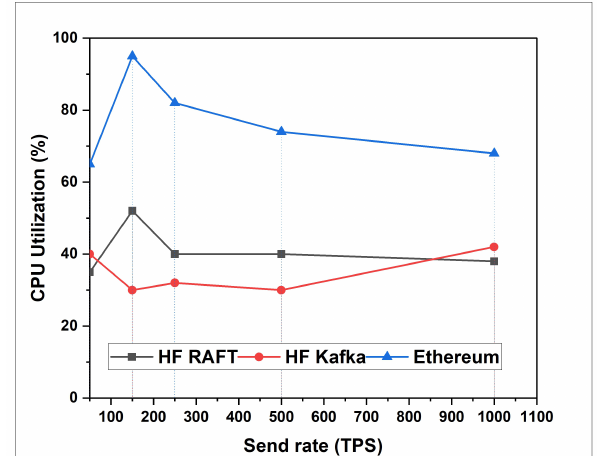
Figure 8. CPU Utilization for Transfer.